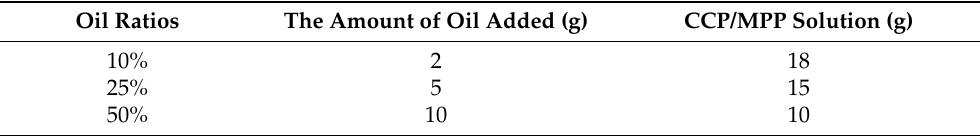
Table 2. The amount of oil additions and the amount of MPP and CCP